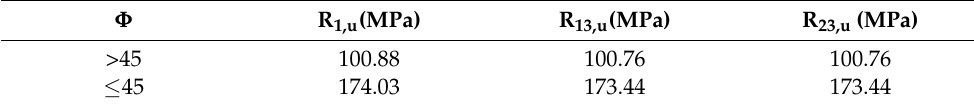
Table 4. The strength parameters of cohesive contact.